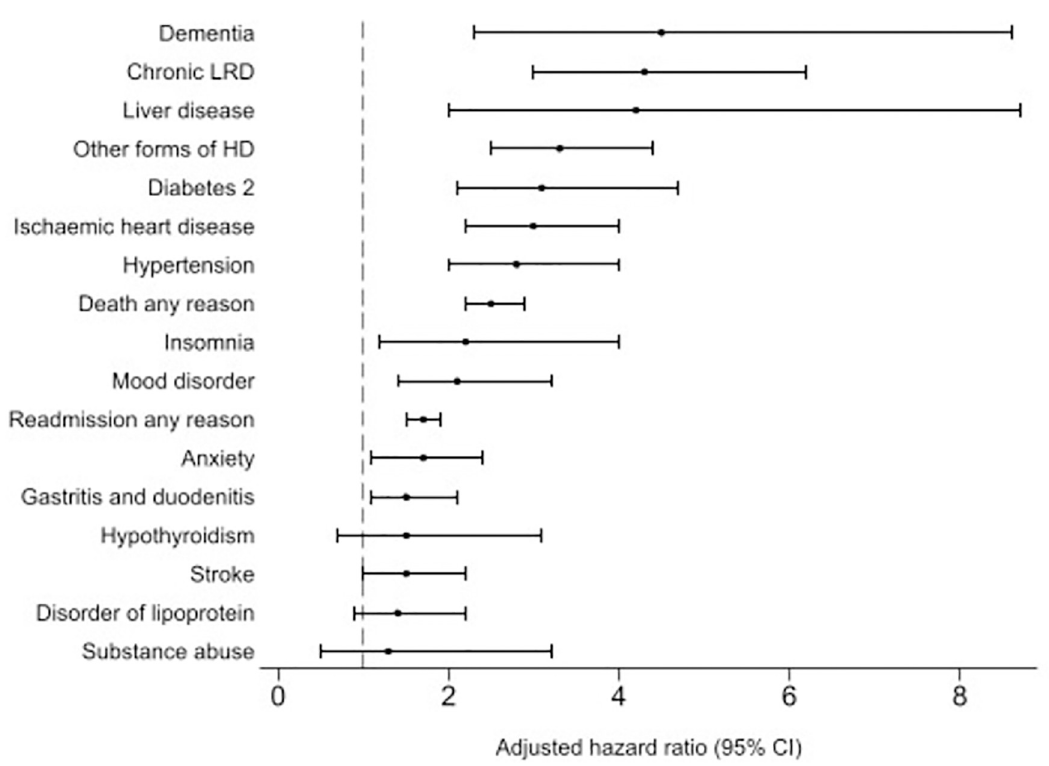
Fig 1. Adjusted HRs comparing COVID-19 hospitalised patients and controls for risk of post-acute COVID-19 sequalae in Estonia 2020–2021. Circles represent the hazard ratio, and the horizontal bar s extend from the lower limit to the upper limit of the 95% confidence interval. Abbreviations LRD lower respiratory diseases; HD heart